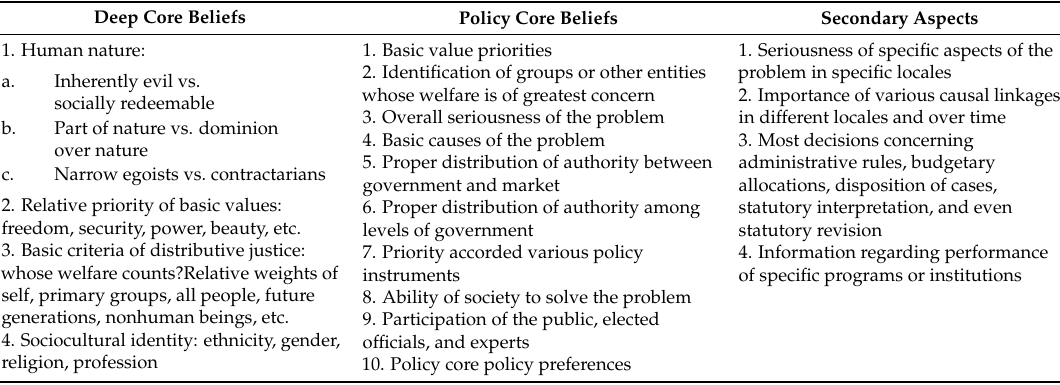
Table 1. The Belief Systems of the Advocacy Coalition